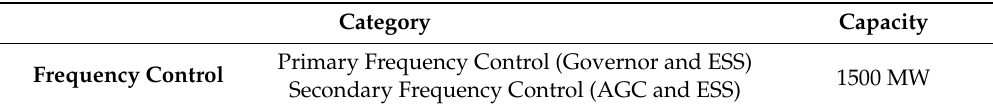
Table 1. Frequency control services in the Korean power system.